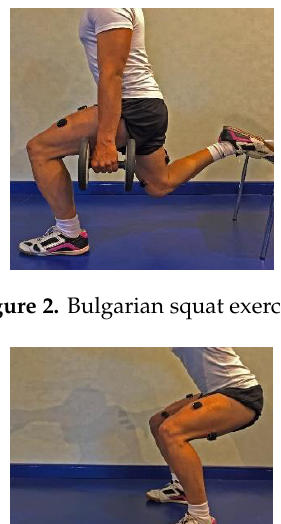
Figure 1. Lunge exercise.